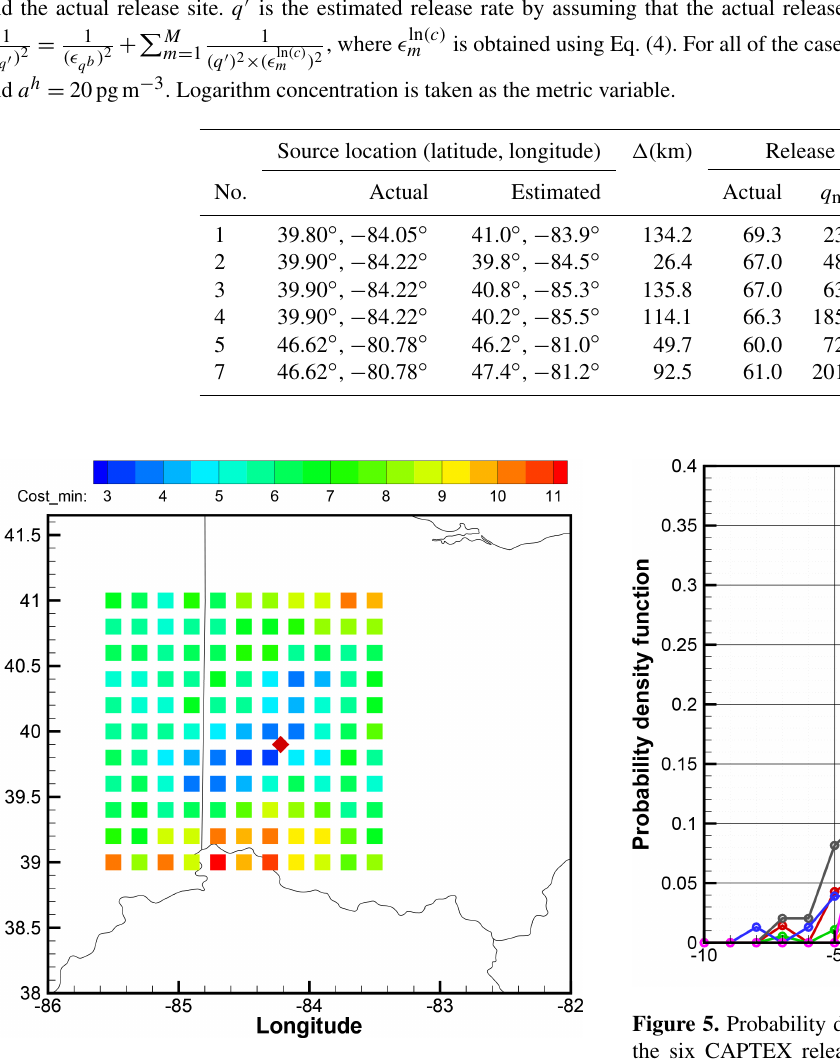
Table 12. The source location (latitude, longitude) and release rate q min identified by the minimal normalized cost function F min for each CAPTEX release. A total of 121 candidate locations are prescribed with 0 . 2 ◦ resolution in both longitude and latitude directions, centered at (40.0 ◦ N, 84.5 ◦ W) for releases 1–4, and at (46.6 ◦ N, 80.8 ◦ W) for releases 5 and 7. (cid:49) is the distance between the point with F min and the actual release site. q (cid:48) is the estimated release rate by assuming that the actual release location is known. (cid:15) q (cid:48) is calculated using